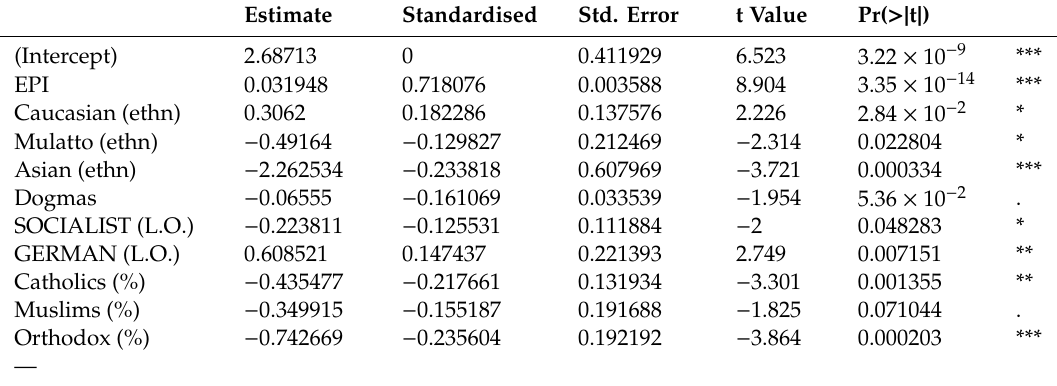
Table 8. Model 2. Competitiveness in the world including the percentage of religious adherents and excluding state religion variables (Author’s figure). Estimate